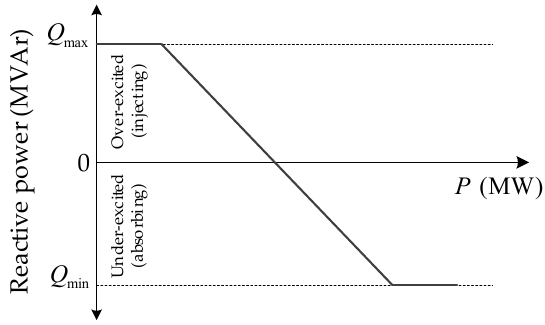
Figure 1. Smart inverter control based on Q(P) − characteristic.